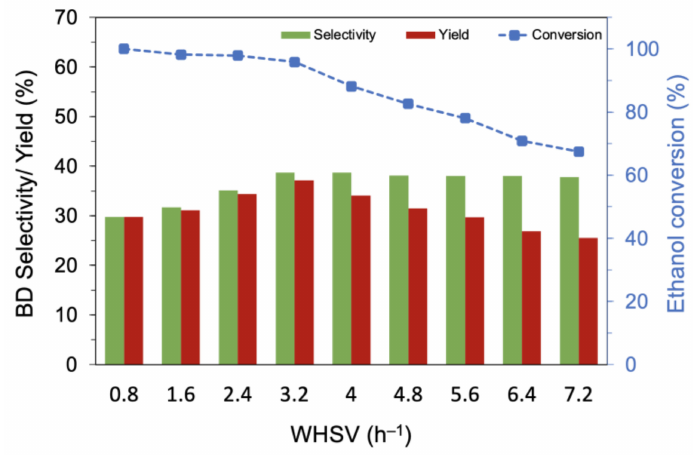
Figure 7. Variation of the butadiene selectivity and yield with ethanol flow rate over MgO-SiO 2 -4 (AE). Reaction conditions: 0.1 g catalyst, 1.5 g glass beads, 475 ◦ C and 55 mL/min He.